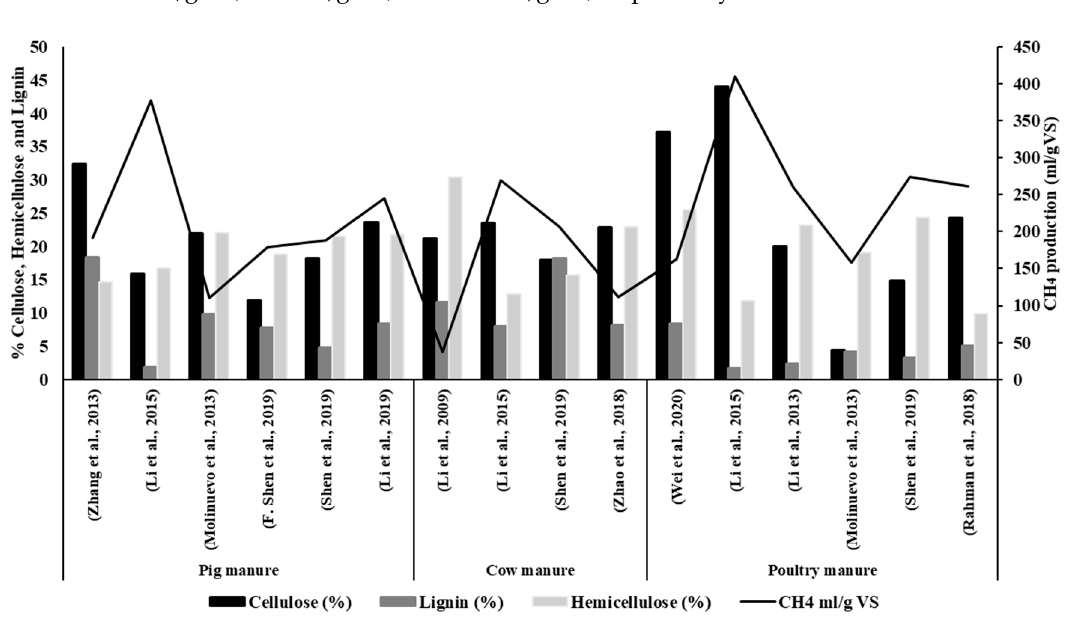
Figure 1. Production of methane from livestock residues and influence of cellulose, hemicellulose and lignin content.